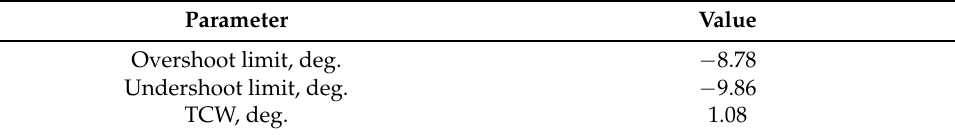
Table 2. Mars SmallSat aerocapture entry